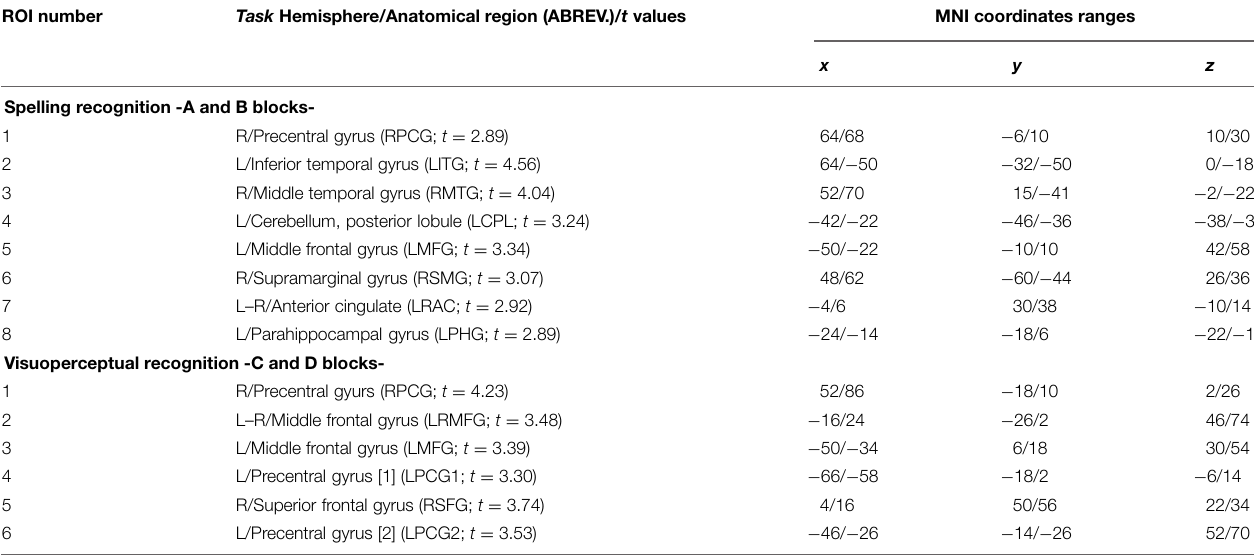
TABLE 2 | Definition of Regions of interest (ROI) from activations by group and task. ROI number Task Hemisphere/Anatomical region (ABREV.)/ t